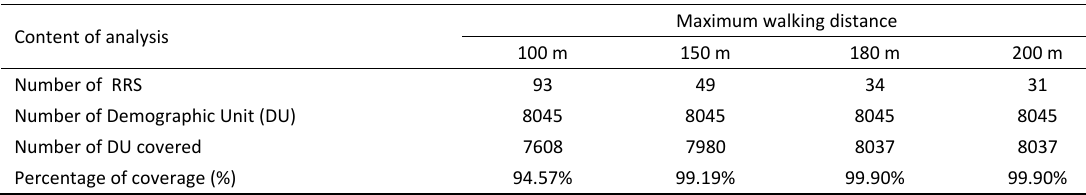
Table 1: Results of location‐allocation analysis for choosing RRS locations